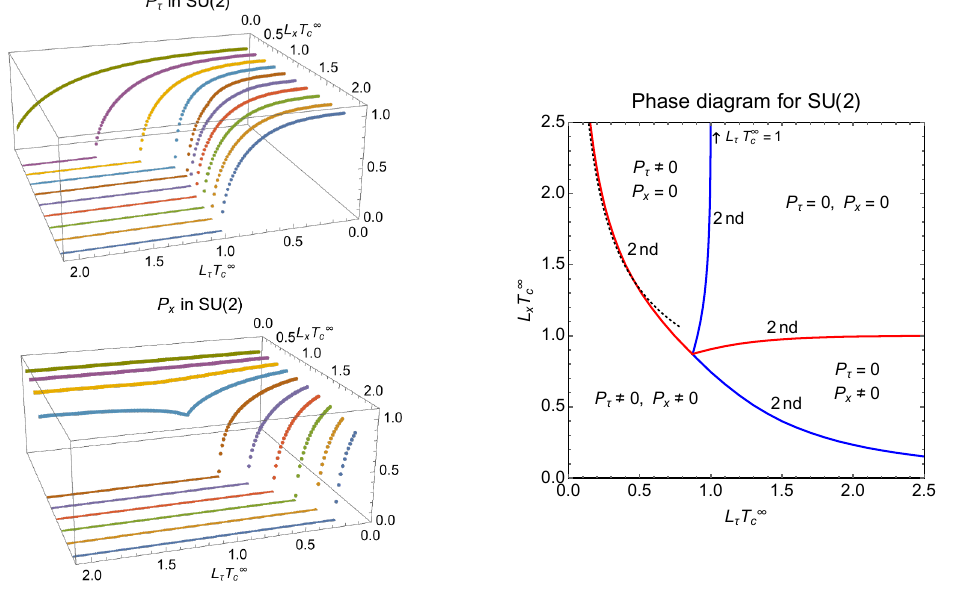
Figure 1. L τ and L x dependence of P τ (upper-left panel) and P x (lower-left panel) for N = 2. The right panel represents the corresponding phase diagram on L τ - L x plane. The detail is provided in the main